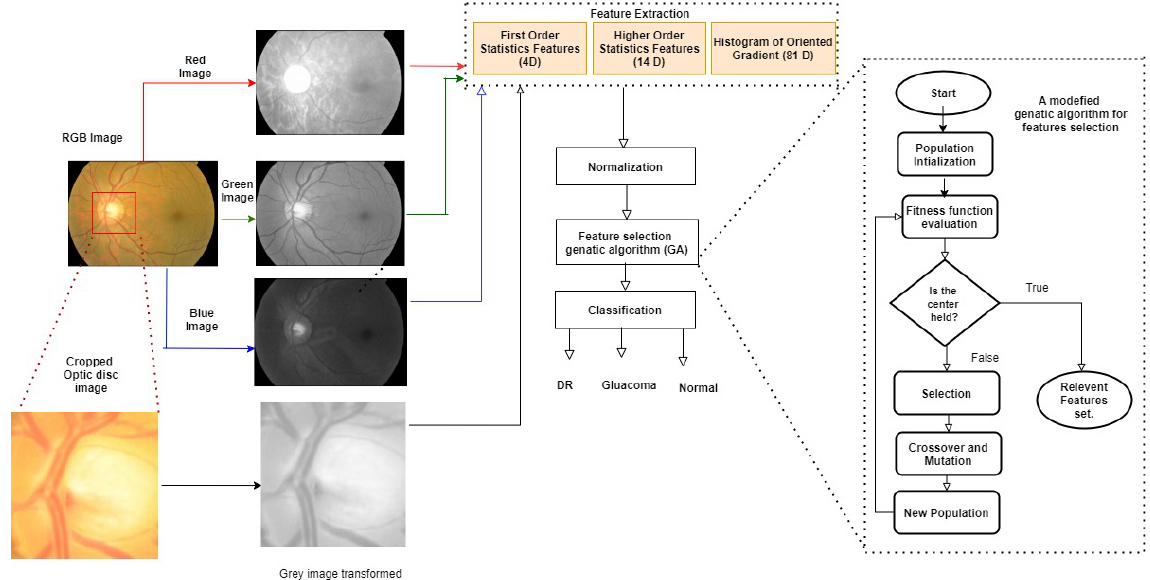
Figure 2. Block diagram of the proposed retinal computer-aided diagnosis